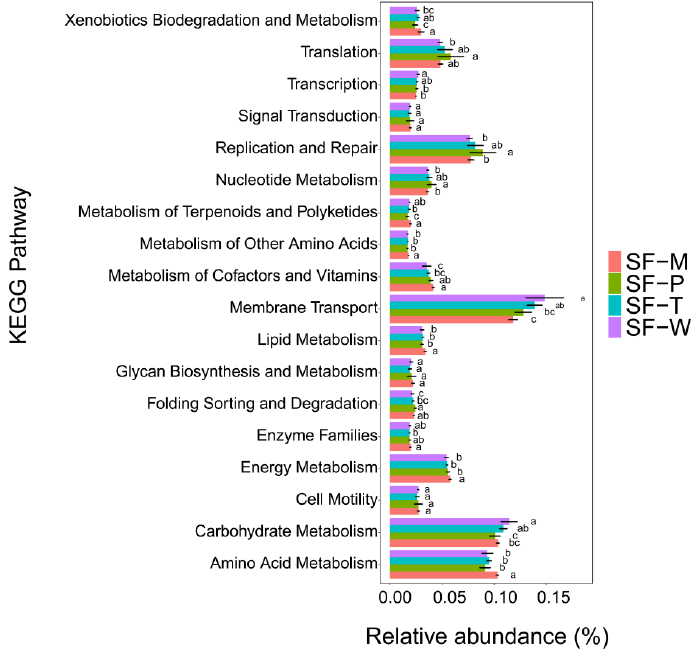
Figure 6. KEGG function prediction and function difference of the gut flora between feeding on four host plants. Different lowercase letters above bars indicate significant differences among samples of the same gene group ( p < 0.05, One-way ANOVA).